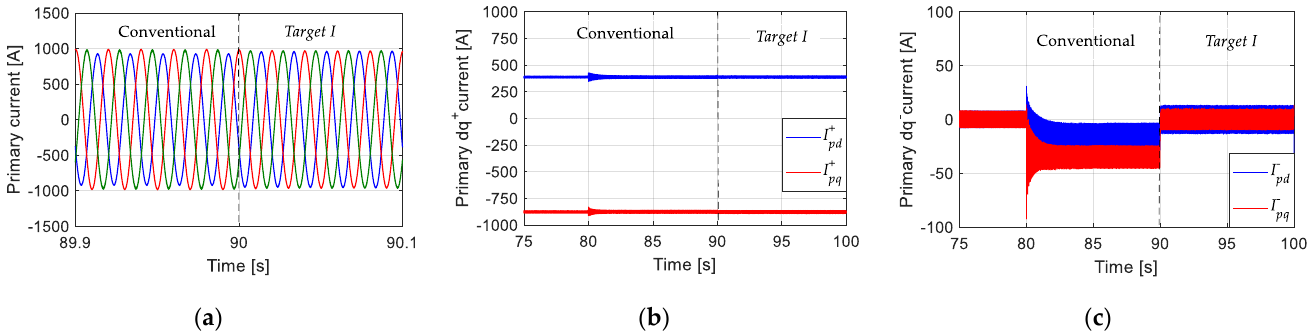
Figure 9. Comparative simulation results for 10% voltage unbalance occurring at 80 s with Target I ( a ) primary current; ( b ) positive components; ( c ) negative components.